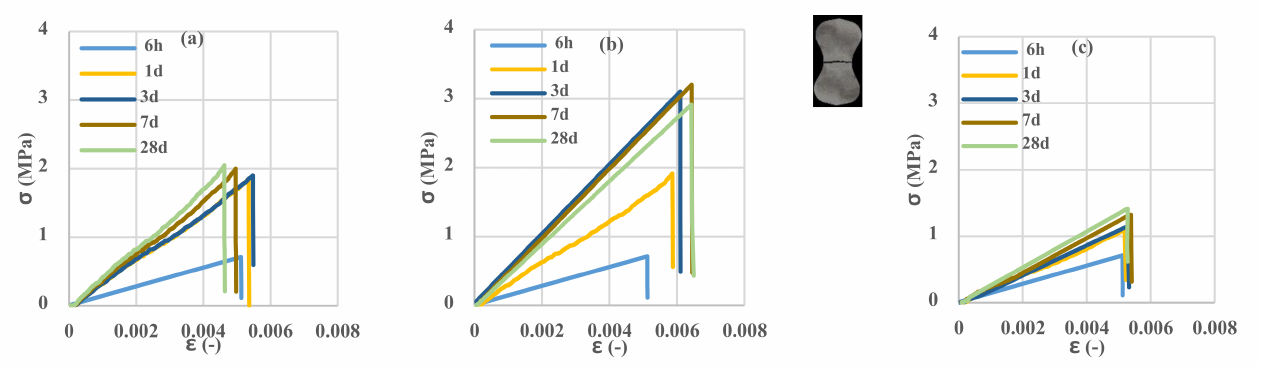
Figure 7. Tensile stress–strain curves of the unreinforced control samples. ( a ) 7 ◦ C, ( b ) 23 ◦ C, ( c ) 50 ◦